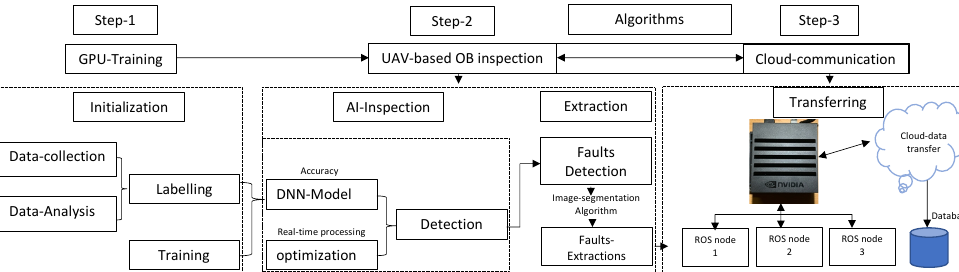
Figure 12. Illustration of AI algorithm development for fault detection. Real-time onboard (OB) inspection provides fault extraction from classified objects. Detected faults are communicated to the Cloud Services to be stored and analyzed by the mission operation